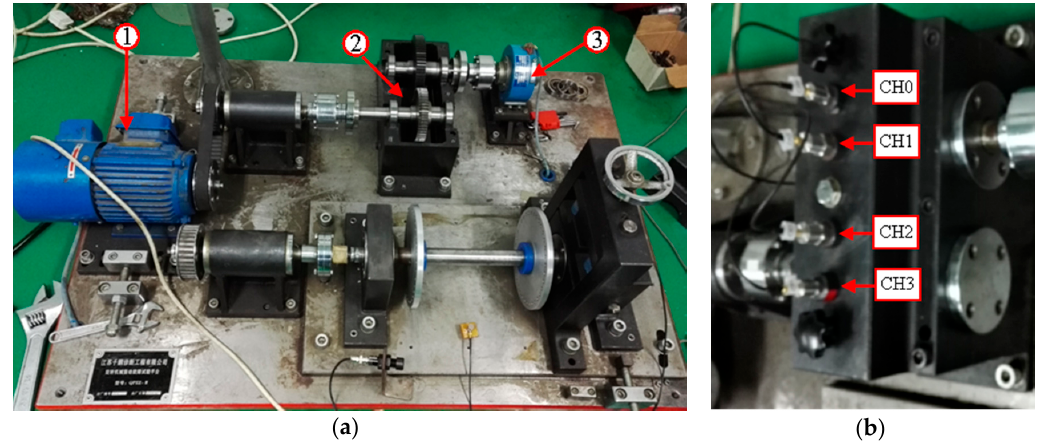
Figure 5. Gearbox test rig: ( a ) Main units: (1) Motor (2) Parallel gearbox (3) Magnetic powder brake ( b ) Locations of sensors. Table 1. Description of four gearbox health conditions.